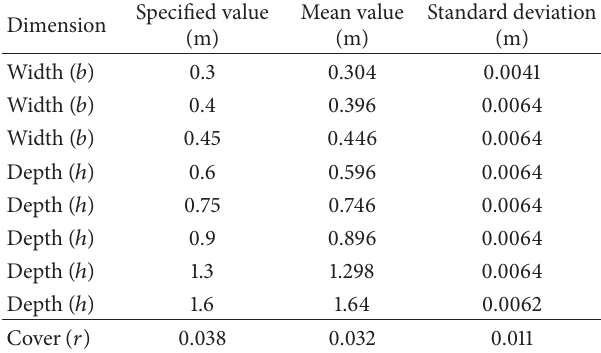
Table 3: Characteristics of the elements analyzed.